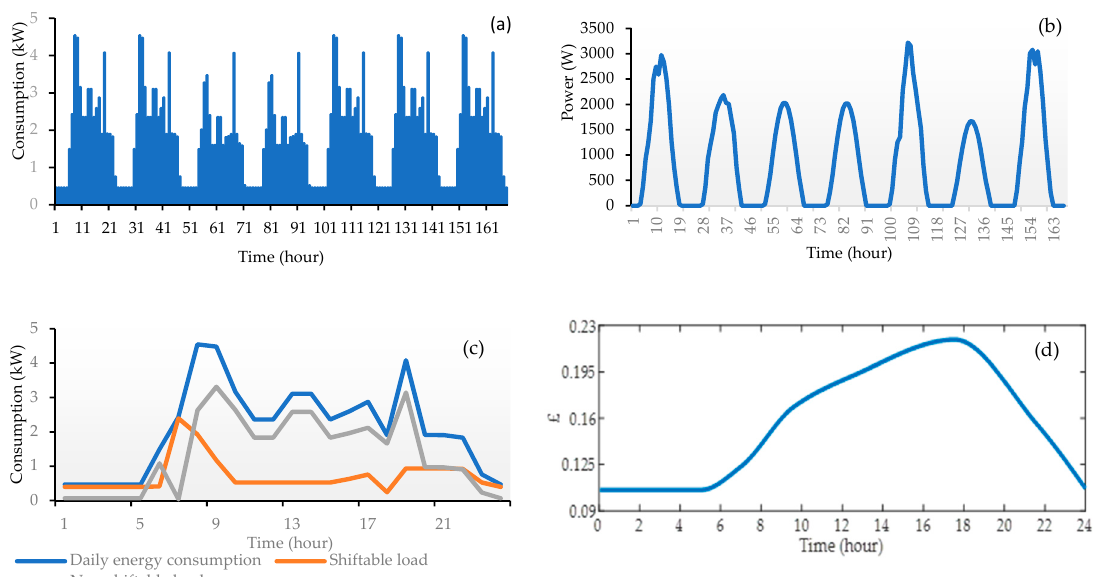
Figure 1. ( a ) Weekly electricity consumption. ( b ) Weekly PV generation. ( c ) Daily load profiles. ( d ) Daily electricity